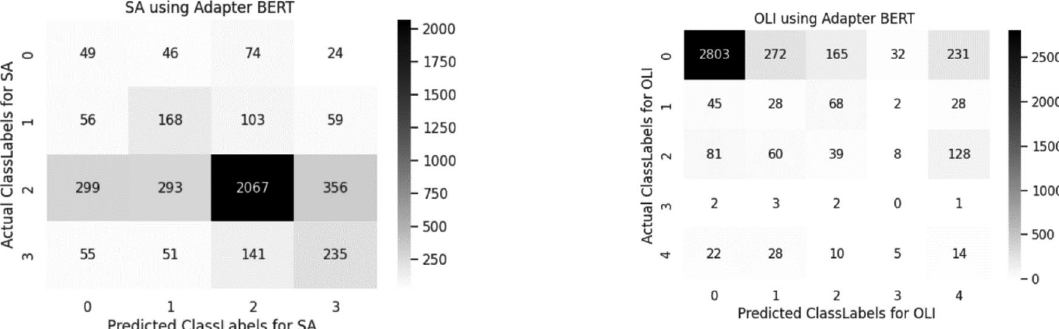
Figure 9. Confusion matrix of adapter-BERT for sentiment analysis and offensive language identification.